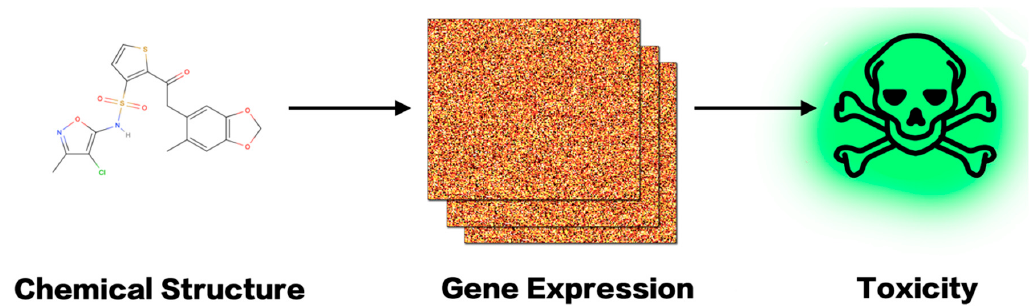
Figure 4. Toxicity prediction with gene expression data.